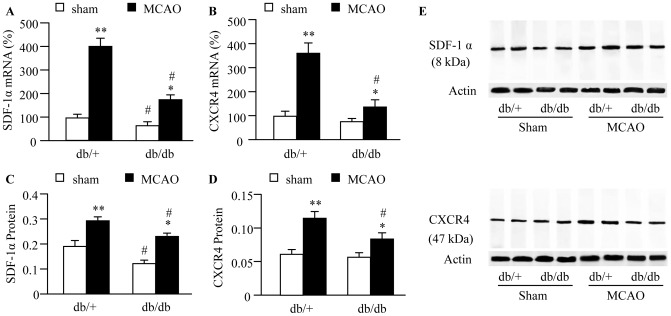
SDF-1α/CXCR4 expression in the brain of db/db mice at basal and in response to ischemia. (A) SDF-1α mRNA expression. (B) CXCR4 mRNA expression. (C) SDF-1α protein expression. (D) CXCR4 protein expression. (E) Representative protein bands of SDF-1α and CXCR4. *P<0.05, **P<0.01 vs. sham; #
P<0.05 vs. db/+, n = 5/group in mRNA analysis, n = 6/group in protein analysis.